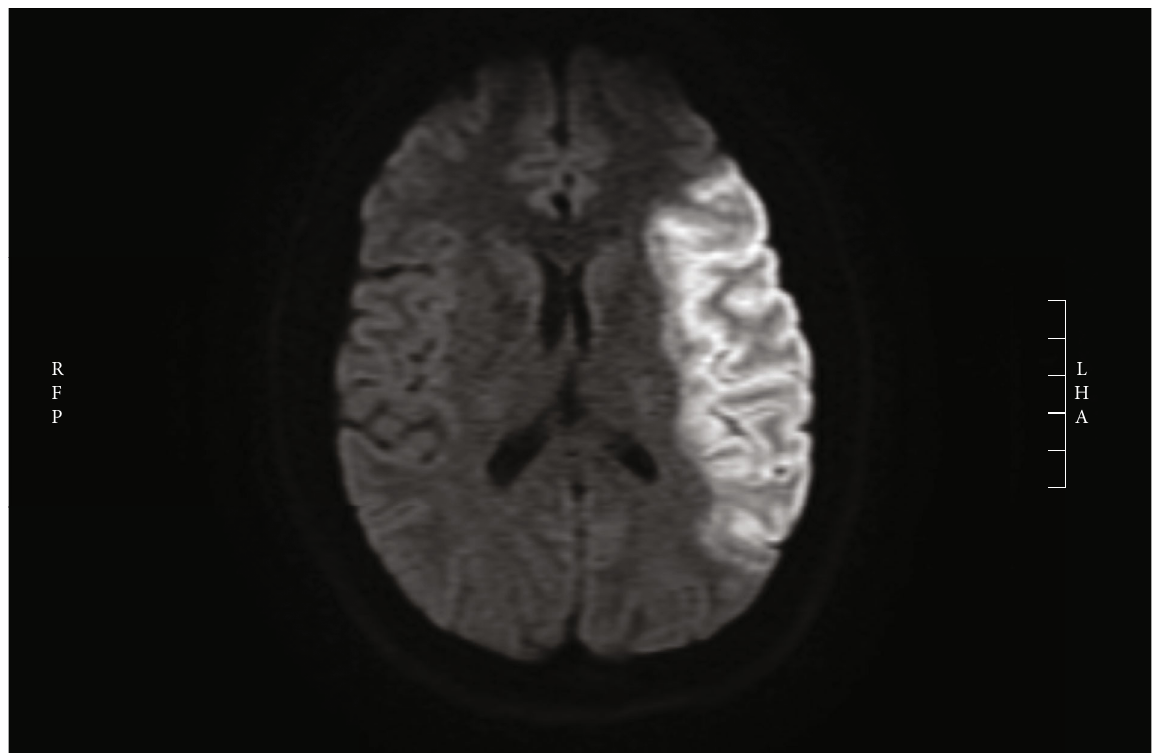
Figure 1: Di ff usion-weighted brain magnetic resonance imaging (MRI) showing acute stroke in the left middle cerebral artery territory.